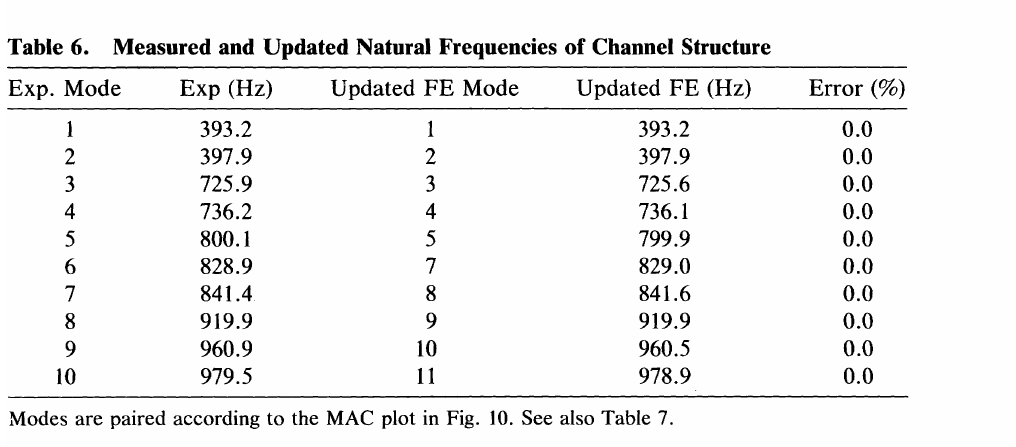
Table 7. MAC Values and Mode Pairs Before and After Updating Initial Mode Pairs